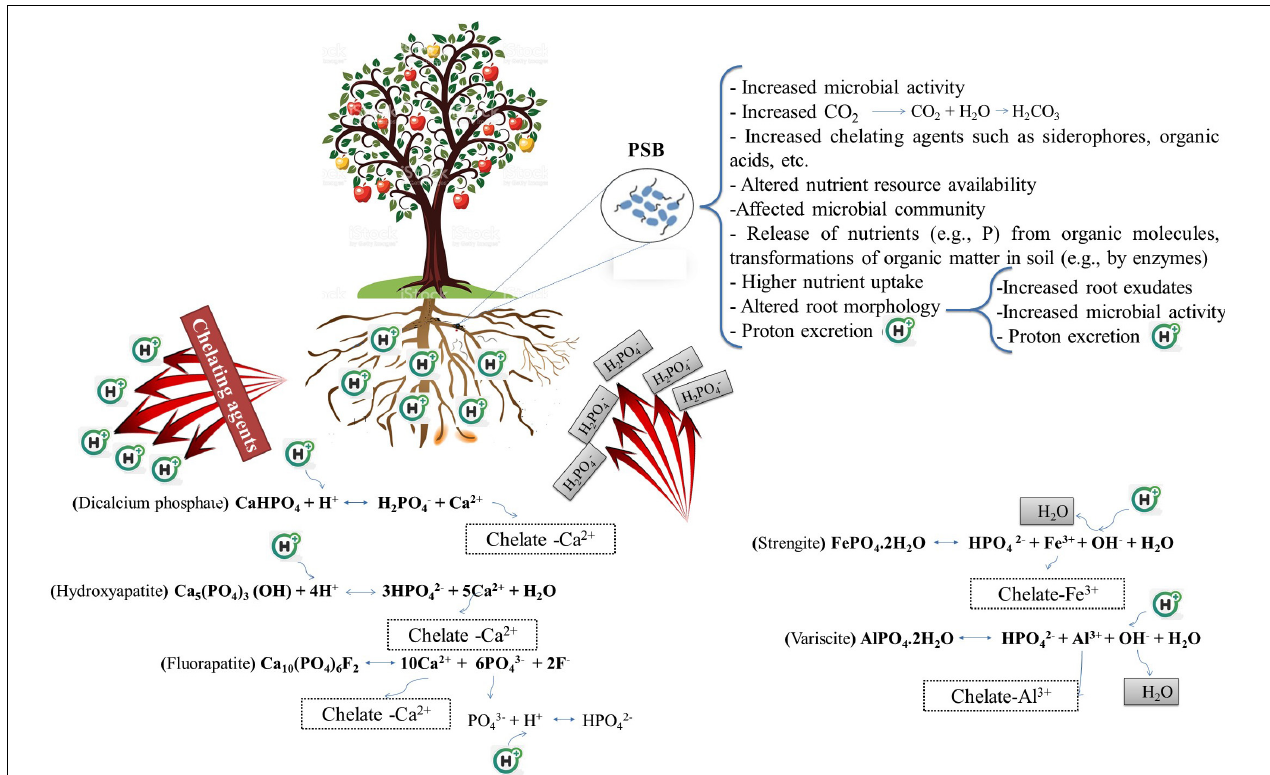
FIGURE 1 | The part that phosphate solubilizing bacteria (PSB) play to improve plant’s ability to acquire the soil phosphorus by altering the sorption equilibria that may increase the net orthophosphate ion transfer into the soil solution. Protons and metal chelating agents are especially effective in solubilizing precipitated phosphorus forms (aluminum phosphates and iron phosphates in acidic conditions, and calcium phosphates in alkaline conditions). Le Chatelier’s principle states that increasing a certain substance’s concentration leads to the balance shifting such that consumption of that substance increases, and lowering the concentration of a material promotes the balance toward the production of the said material. Chelating agents (organic anions, siderophores, etc.) remove Al 3 + , and Ca 2 + , and Fe 3 + ions from the reaction and cause the balance to shift such that more H 2 PO 4 − and HPO 42 − are produced. The addition of H + ion also causes the balance to be adjusted to encourage the reduction of H + ions, leading to more H 2 PO 4 − and HPO 42 − to be